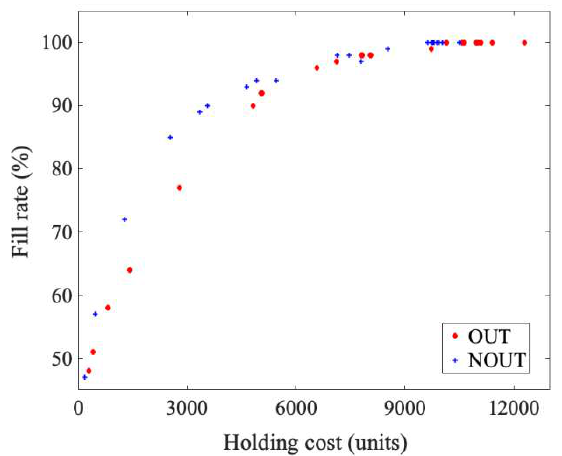
Figure 7. Fill rate vs. holding cost trade-off for network N1. Table 8. Policy performance in network N1.